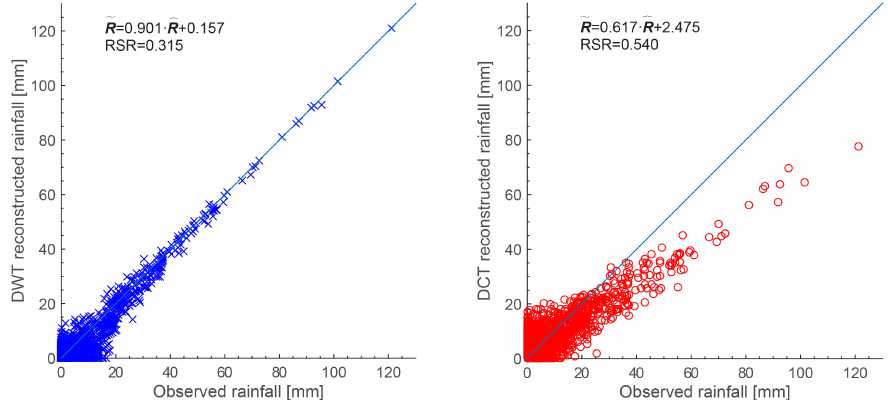
Figure 7. Comparison of the reconstructed DCT and DWT signal for the Leaf River (Collins) catchment using 20 POP.